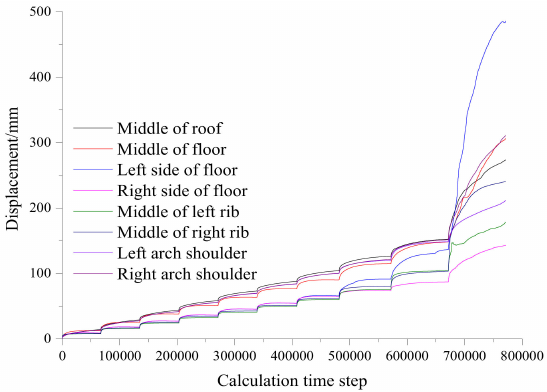
Figure 12. Displacement evolution characters in critical points during the excavation unloading process.